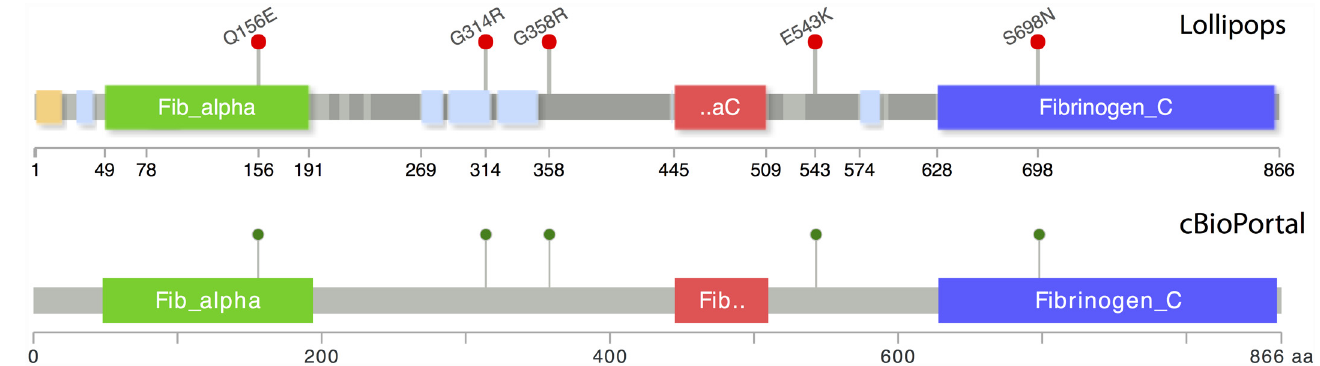
Fig 1. Comparison of FGA plots from Lollipops tool (top) and cBioPortal (bottom). Lollipops selects more informative axis labels and shows greater information density with the same plot size. Amino acid axis labels for domain start and stop positions, as well as exact marker locations, are clearly displayed for precision interpretation. In addition, lollipop labels are supported, and putative disordered regions (dark gray), low complexity regions (cyan), and signal peptides (orange) show additional structural information from Pfam without excessive